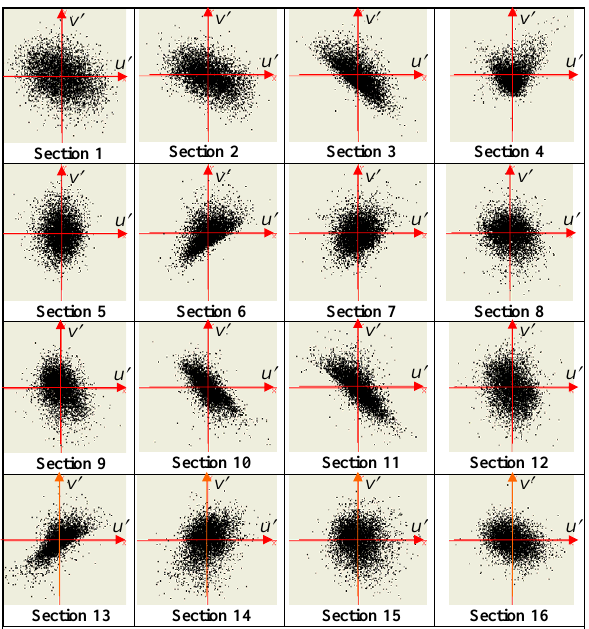
Figure 5- Distribution of instantaneous velocity fluctuations at 20 mm from the bed for Fig. 5. Distribution of instantaneous velocity fluctuations at 20mm 16 sections along the flume from the bed for 16 sections along the